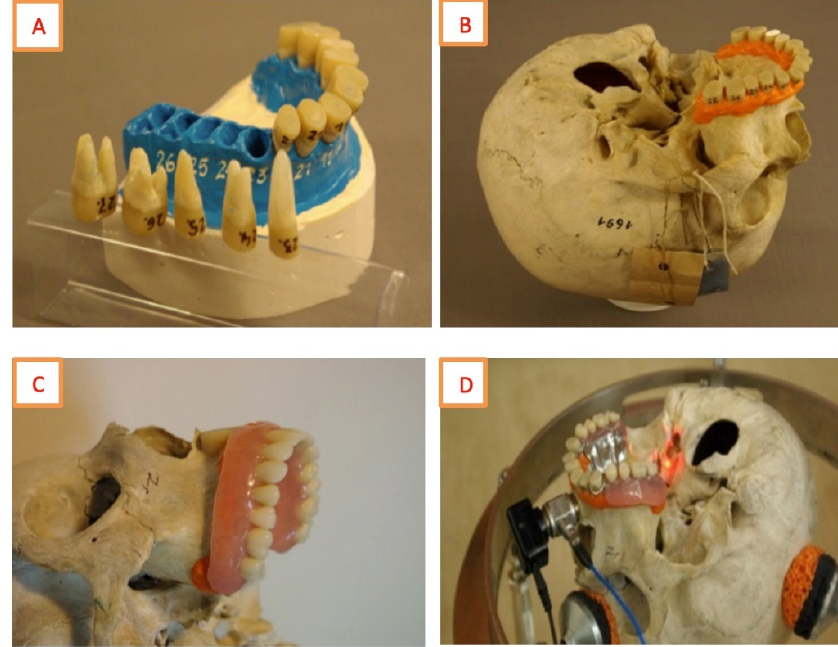
Figure 1. A. Gypsum model with reconstructed teeth, B. Reconstructed teeth on the